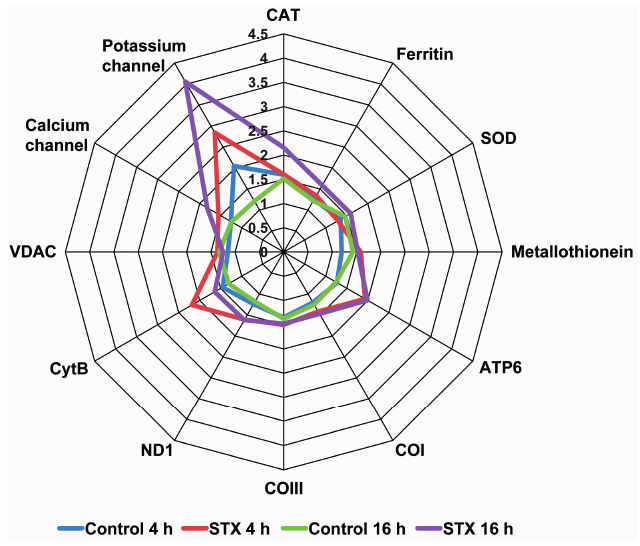
Figure 4. Radial graph of relative transcript levels for studied genes in cultured hemocytes after exposure to STX or a control solution. Cells were seeded in six-well plates, and after three days of culturing, cells were incubated with 100 nM STX for 4 or 16 h. With respect to C-type lectin and toll-like receptor genes, the transcriptional activity revealed post-exposure to STX (Figure